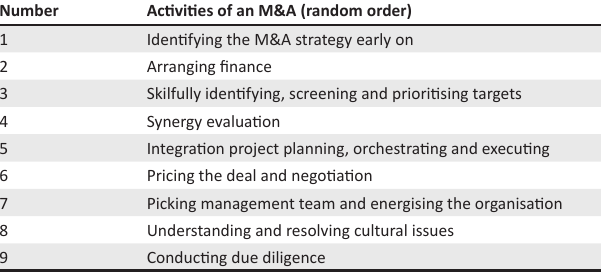
TABLE 1: Activities of a mergers and acquisitions to be ranked by participants. Number Activities of an M&A (random